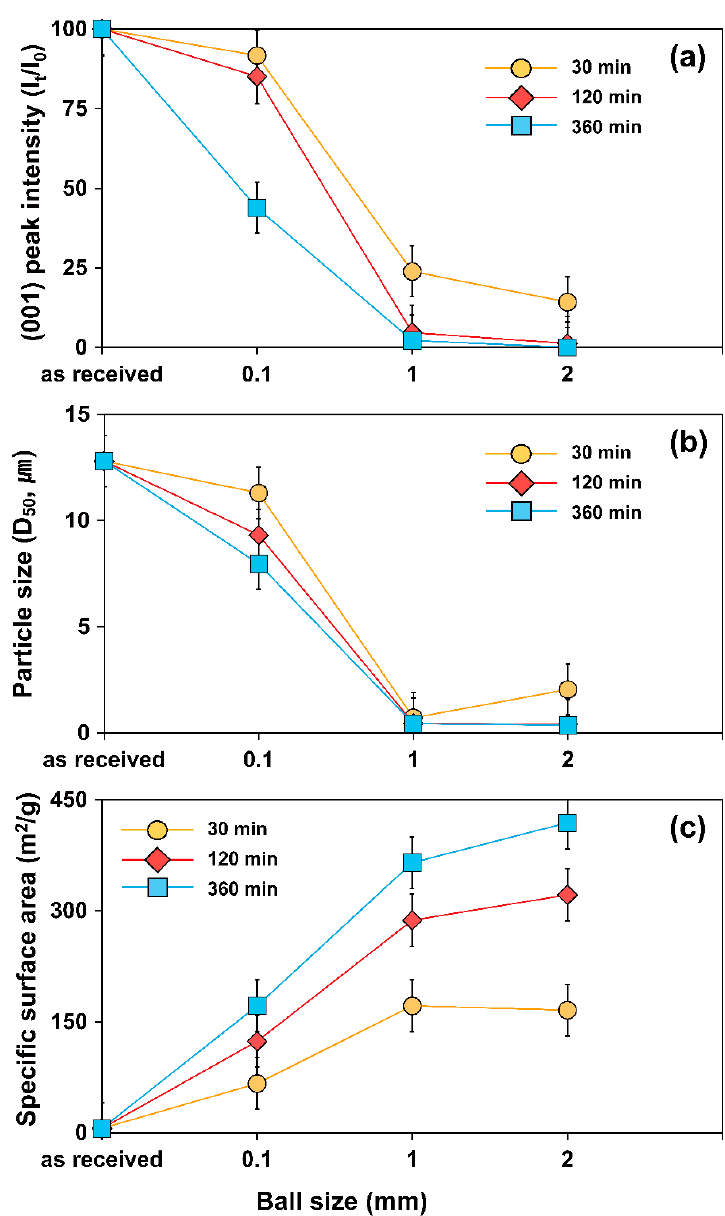
Figure 10. Effect of ball size for high ‐ energy ball milling on ( a ) relative intensities of (001) XRD peak, ( b ) Figure 10. E ff ect of ball size for high-energy ball milling on ( a ) relative intensities of (001) XRD peak, particle size (D 50 ), and ( c ) specific surface area. ( b ) particle size (D 50 ), and ( c ) specific surface